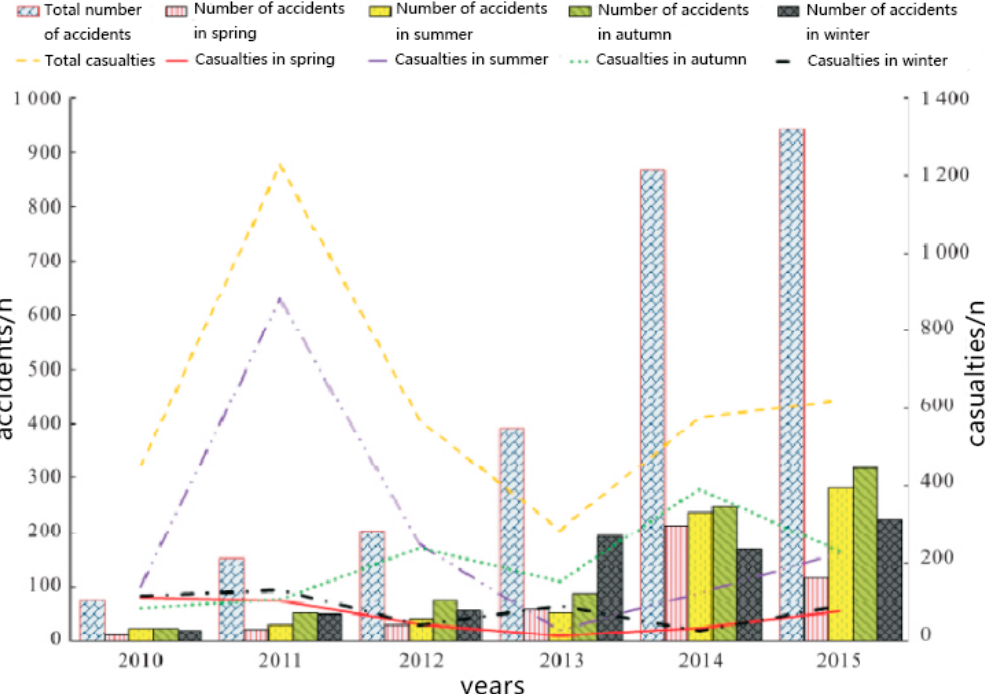
Figure 1. Total number of deaths and total casualties of hazardous chemicals spills in China from 2010 to 2015.